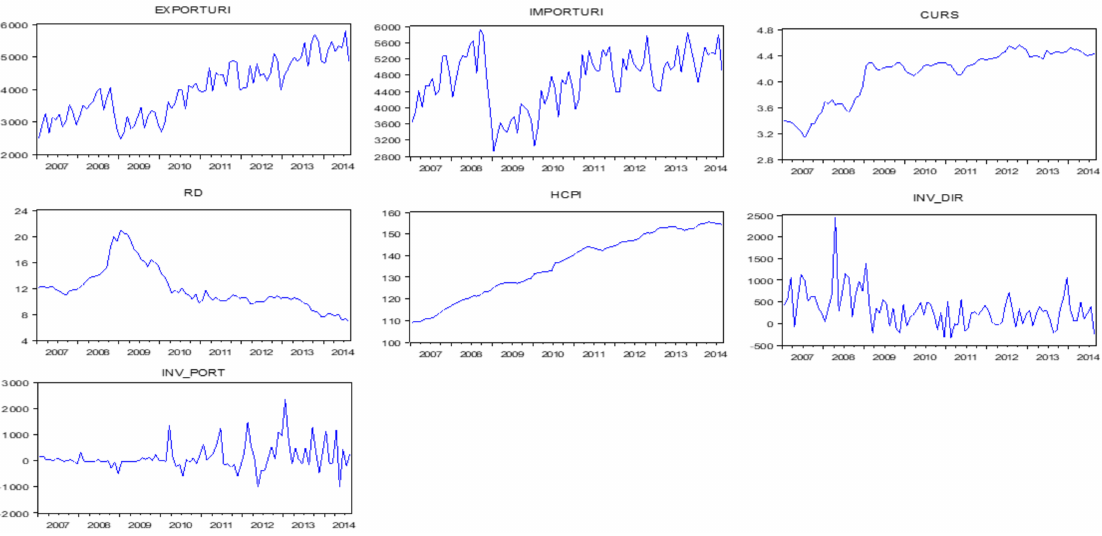
Figure 1. Variables’ Time Series between January 2007 and August 2014.